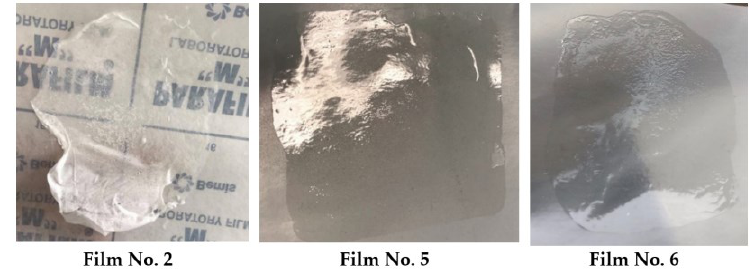
Figure 1. Appearance of